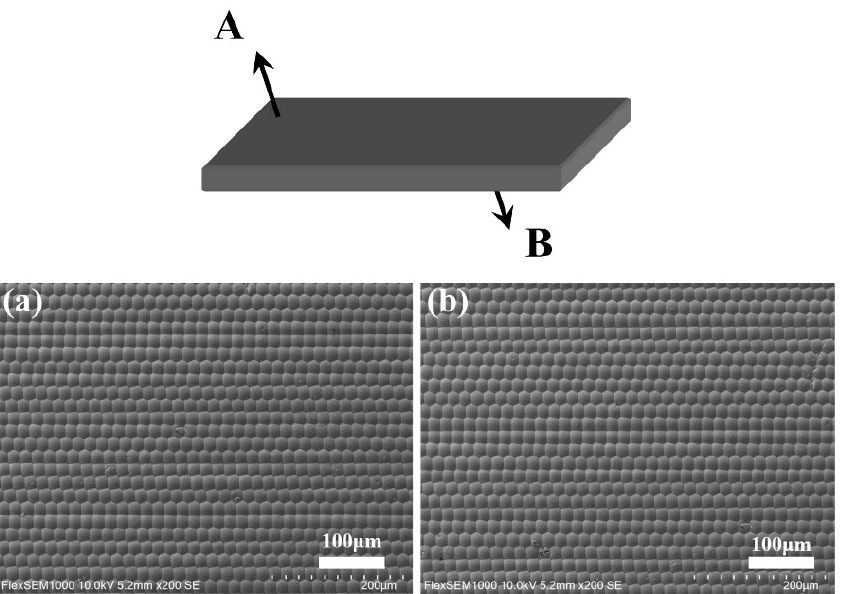
Figure 4. ( a ) Top-view (A-side of a double-sided MLA) SEM image of the quasi-periodic ChG MLA. ( b ) SEM image of the B-side of the quasi-periodic ChG MLA.